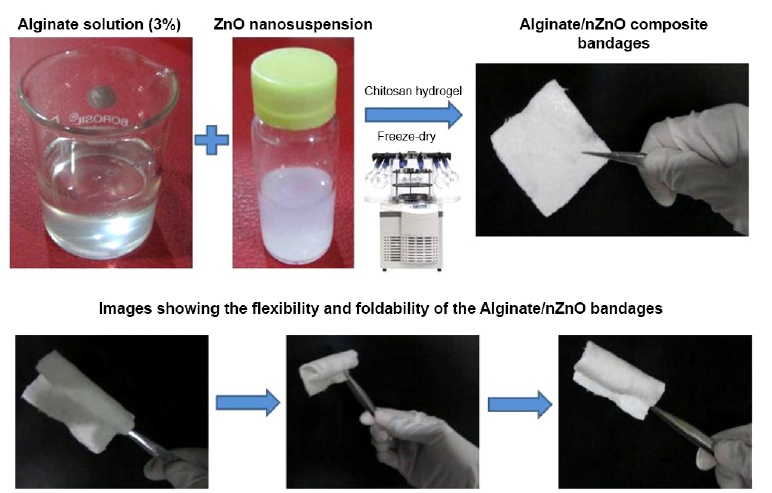
Figure 11. Photographical representation of the preparation of alginate hydrogel/zinc oxide nanoparticle (nZnO) composite bandages. Reprinted from [155].